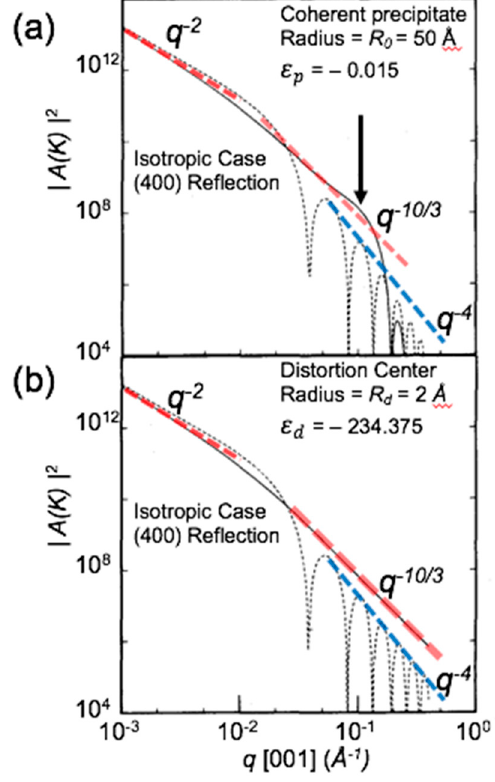
Figure 9. Log–log plot of di ff use scattering cross-sections for a 50-Å precipitate (upper) and for a corresponding “infinitesimal distortion center” (below) where q is along the ± [100] direction. The solid lines correspond to positive q -values and the dotted lines correspond to negative q -values. As labeled, the thick red dashed lines correspond to slopes of − 2 and − 10 / 3 at small q and large q , respectively. The thick blue dashed lines refer to a slope of − 4. Adapted from Figure 5 in Reference [40] with permission.